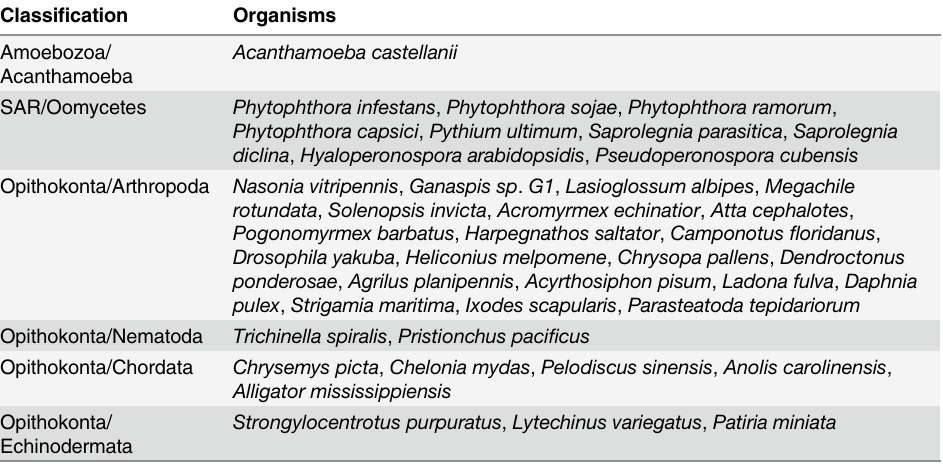
Table 1. Organisms with Utopia families.